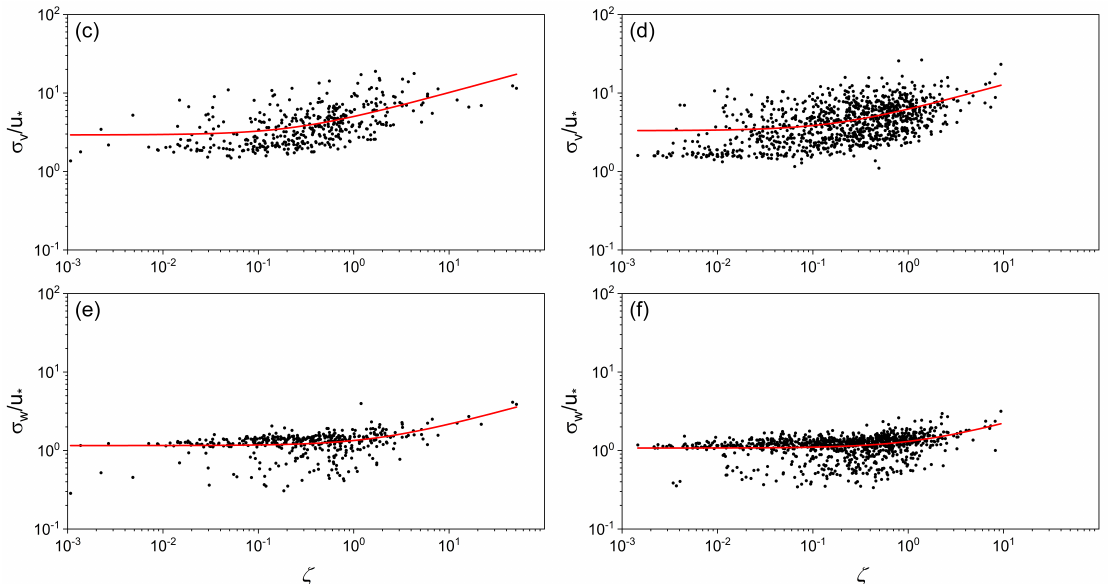
Figure 1. Cont . Figure 10. Normalized standard deviation of longitudinal wind velocity ( σ u / u ∗ ), lateral wind velocity ( σ v / u ∗ ), and vertical wind velocity σ w / u ∗ for stable stratification conditions at the PV plant (left: ( a , c , e )) and the reference site (right: ( b , d , f )) from June to October 2019. The red solid line represents the empirical relations applied to the observed